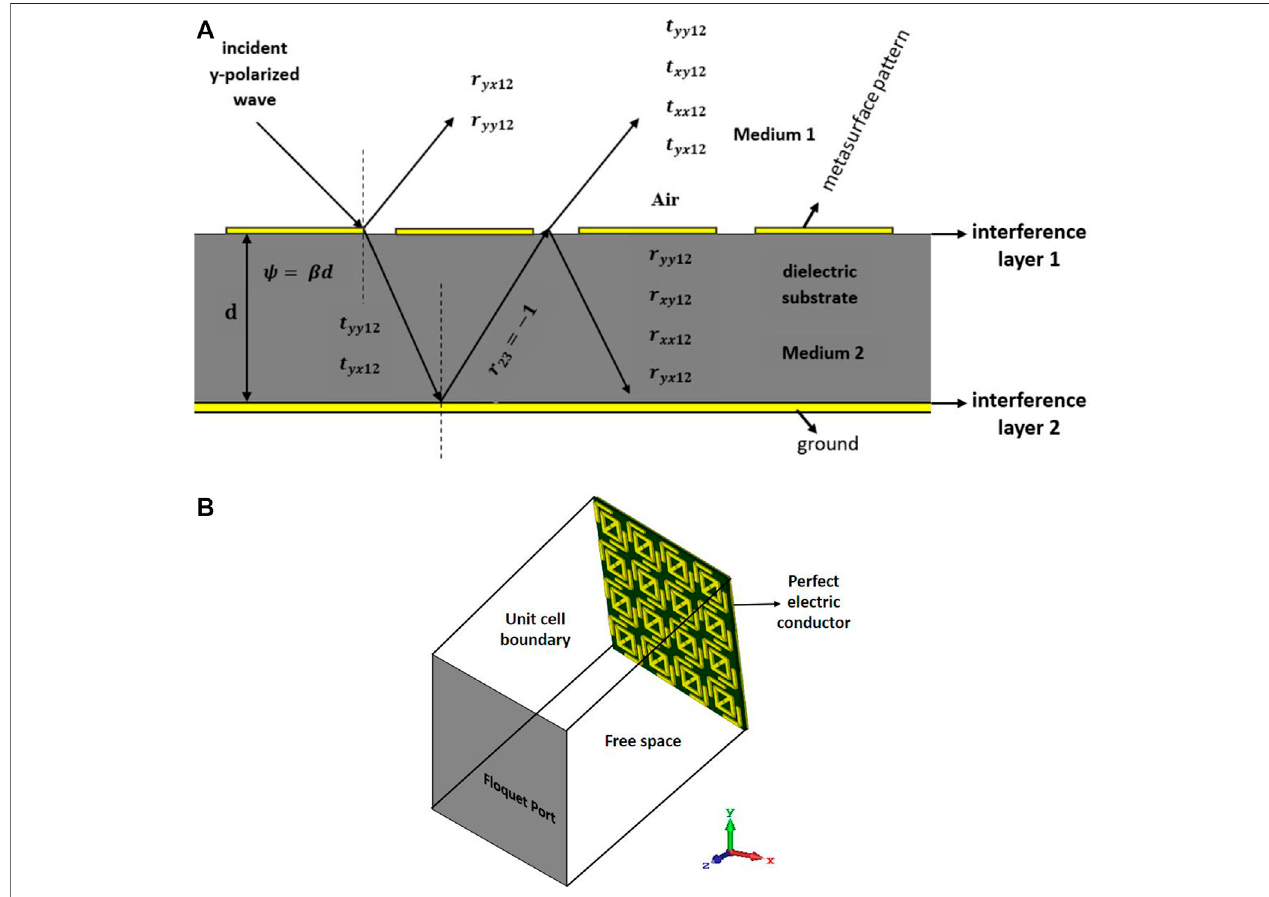
FIGURE 2 | (A) Re fl ectance and transmission of waves based on interference theoretical model and (B) schematic description of simulation.